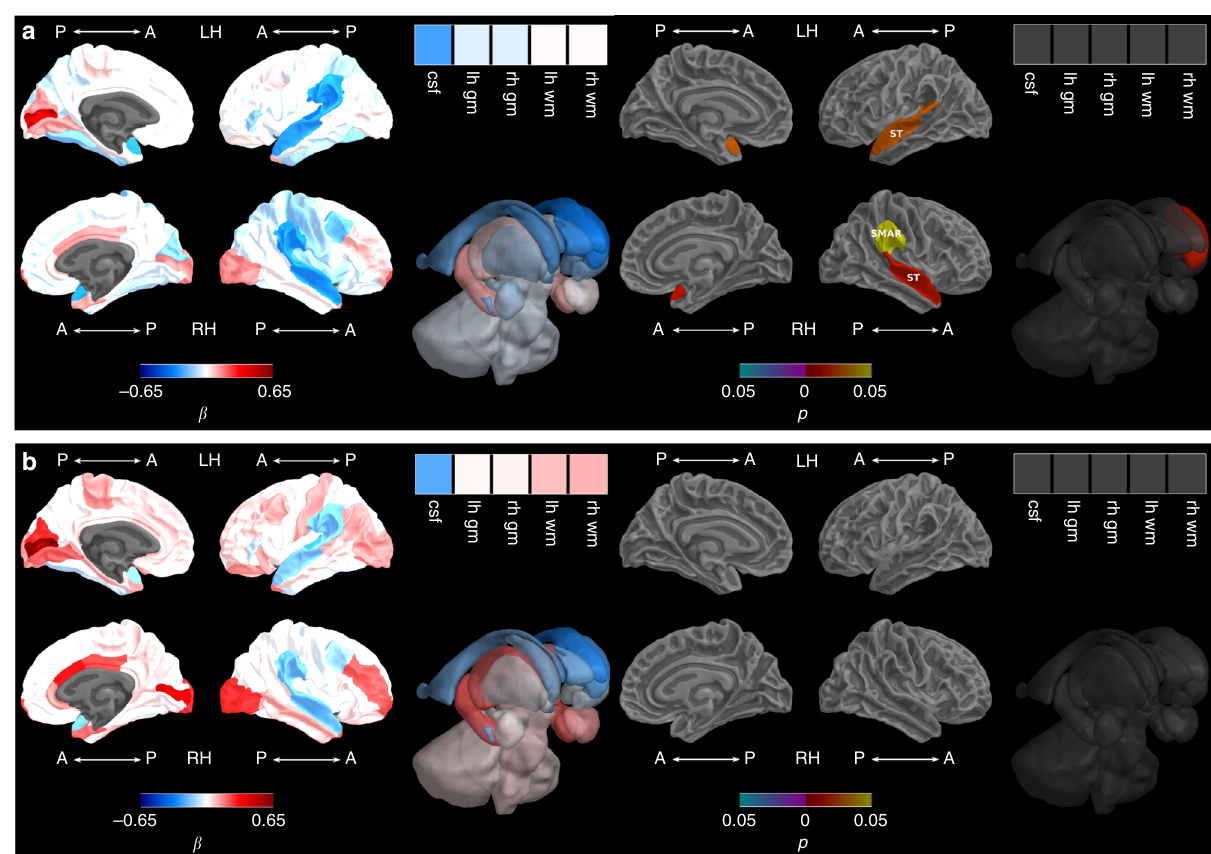
Fig. 3 Growth restriction and brain growth from term-equivalent to 7 years. a Before and b after adjusting for total brain volume. Note: Small for gestational age-by-time regression coef fi cients from linear mixed effects models ( β ) in blue refer to negative associations (slower growth in children born small compared with appropriate for gestational age) and in red refer to positive associations (faster growth in children born small compared with appropriate for gestational age), with darker coloured regression coef fi cients indicating stronger associations; Interaction p values are false discovery rate corrected and darker coloured p values indicate stronger signi fi cance; Boxes in the top right corner of the fi gures represent global brain volumes. A = anterior, P = posterior, LH = left hemisphere, RH = right hemisphere, csf = cerebrospinal fl uid, gm = grey matter, wm = white matter, ST = superior temporal, SMAR =